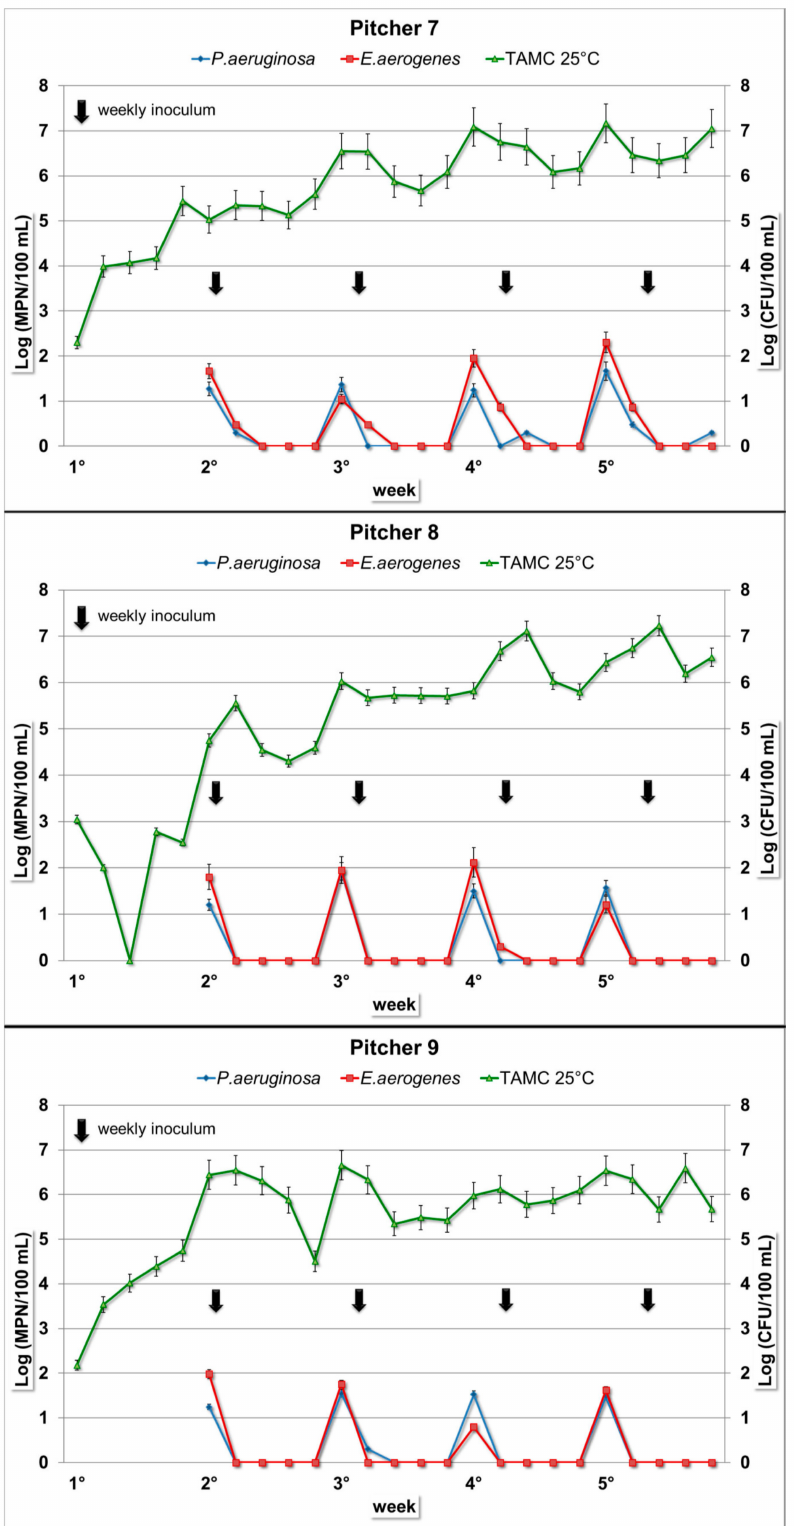
Figure 3. Bacterial concentration trends in daily composite samples in Filter Jugs 7–9. Arrows represent weekly inoculum for both bacteria ( E. aerogenes and P. aeruginosa ). The y -axes show: E. aerogenes and P. aeruginosa concentrations expressed in MPN / 100 mL (left); TAMC at 25 ◦ C expressed in CFU / 100 mL